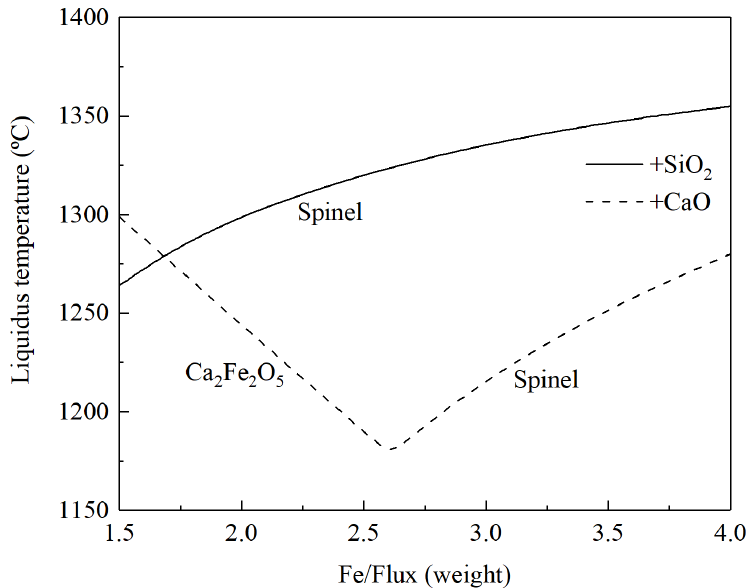
Figure 4. Effect of SiO 2 or CaO on liquidus temperatures of converting slag at a fixed copper content 98.5% in blister copper.